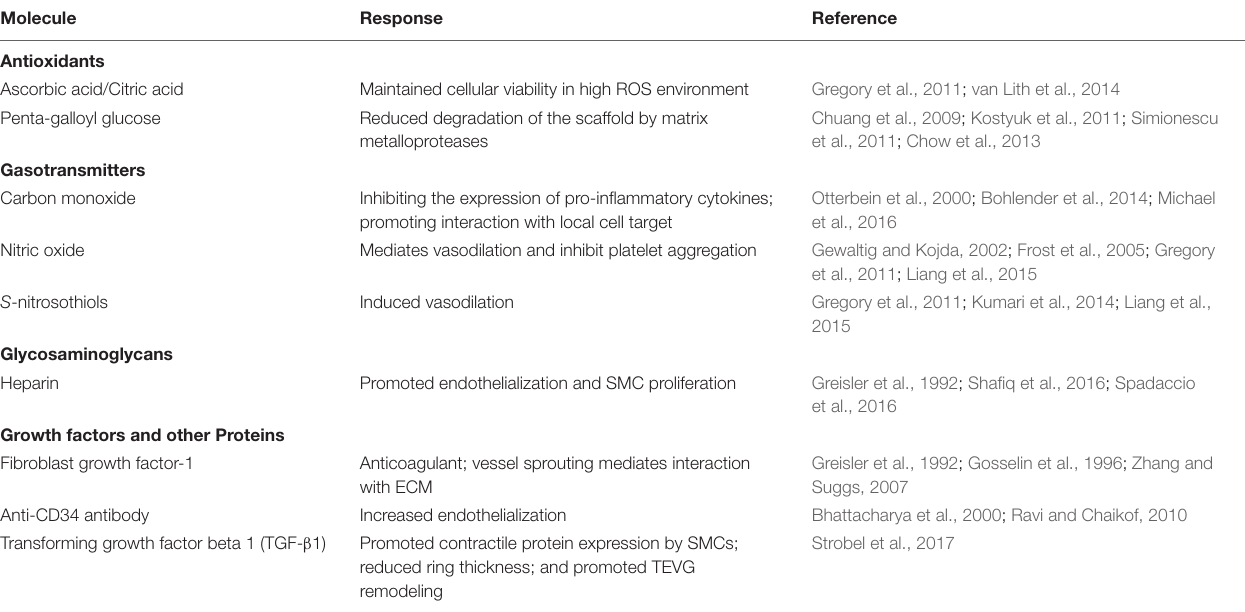
TABLE 1 | Bioactive molecules released from vascular